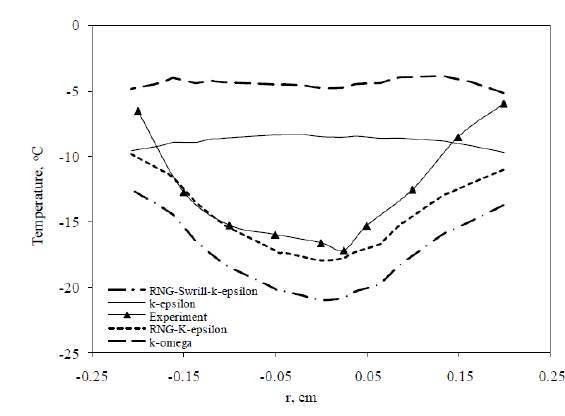
Figure 5. Experimentally measured and predicted temperature dis- tribution as a function of radius towards cold end at axial position of 0.3 cm at 4 bar inlet pressure.